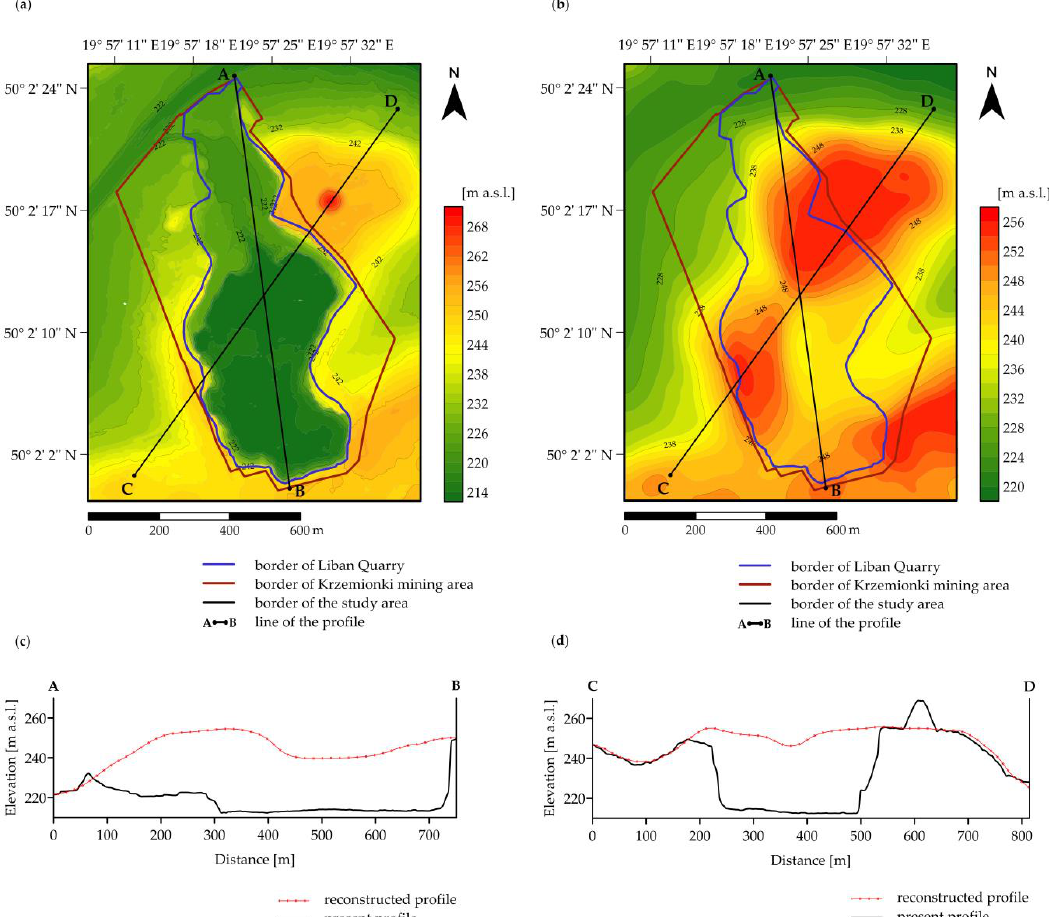
Figure 12. Topographic profiles: ( a ) before the commencement of mining operations; ( b ) after the conclusion of mining operations; and topographic profiles for the Krzemionki mining area and its surroundings: ( c ) A–B profile; (d) C–D profile.